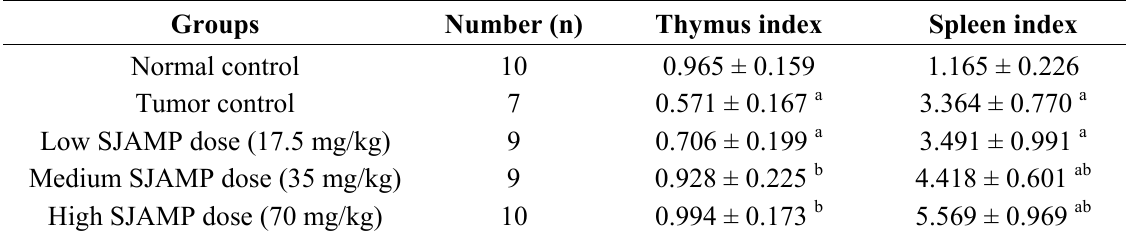
Table 5. Effect of SJAMP on thymus and spleen indices in rats with DEN-induced HCC ( x ±